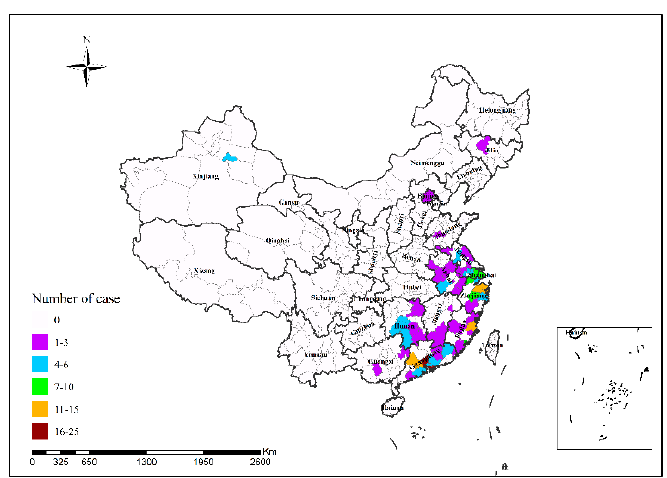
Figure 3. Spatial pattern of H7N9 outbreaks in China in 2014.